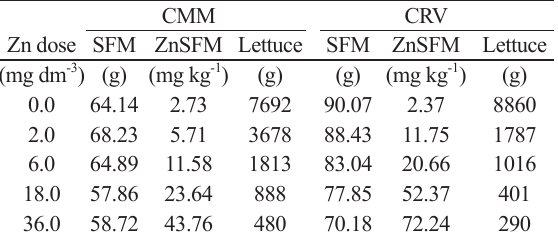
Fresh matter weight of shoots (SFM), Zn concentrations in fresh shoot matter* (ZnSFM) and amount of lettuce (Lettuce) to be consumed daily to reach the Zn provisional tolerable daily intake limit** for cultivars CMM and CRV, 44 days after seedlings transplanting to soil treated with Zn